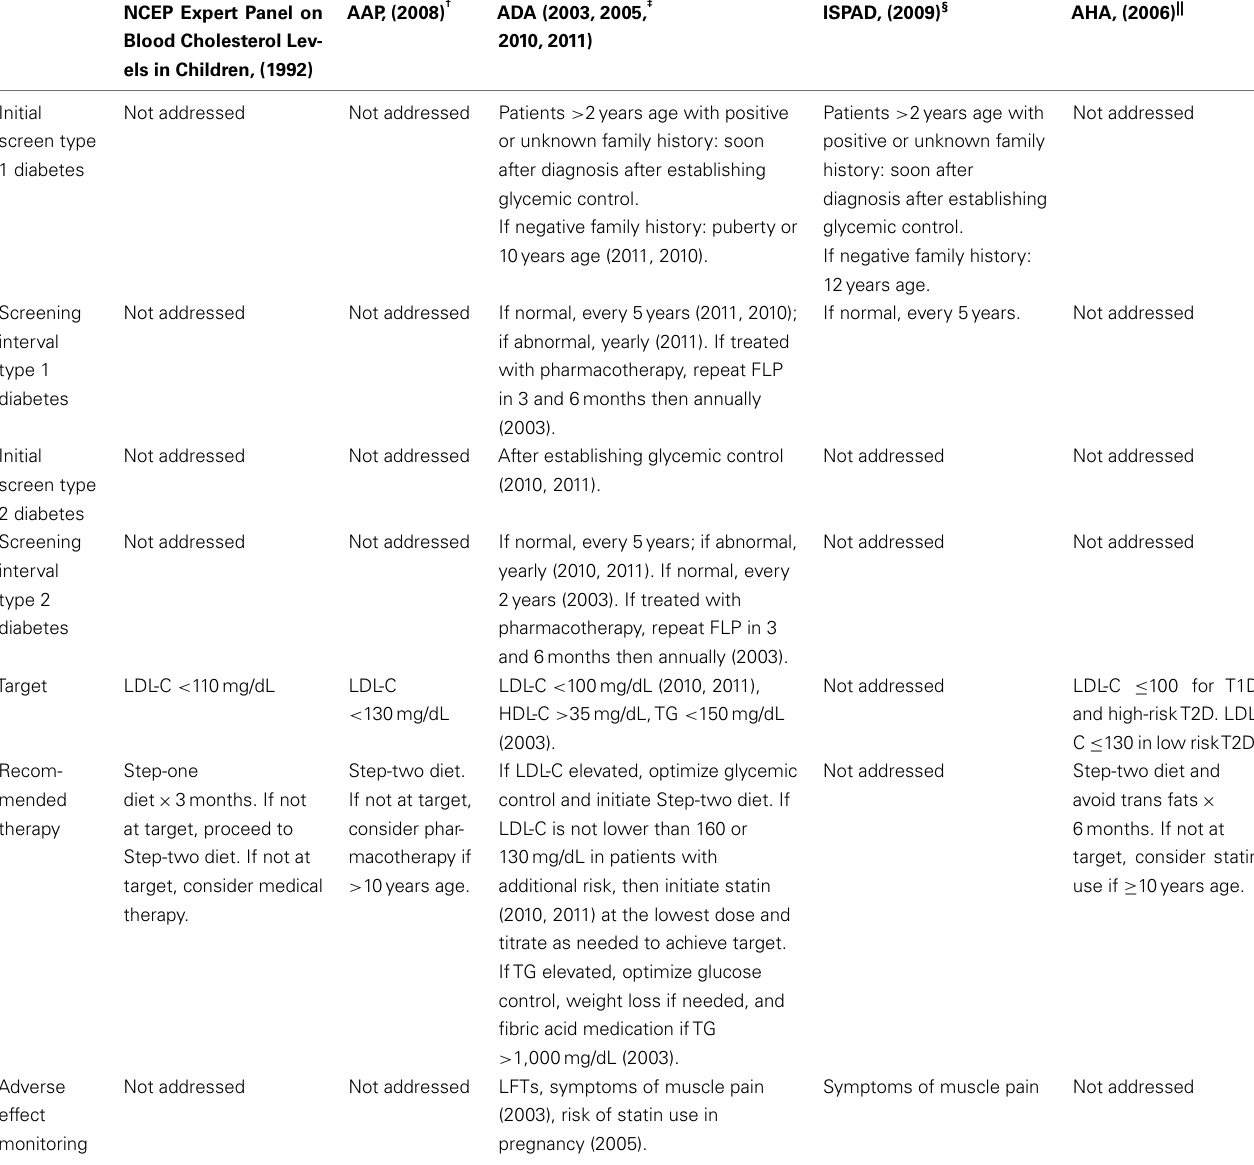
Table 1 | Cholesterol guidelines